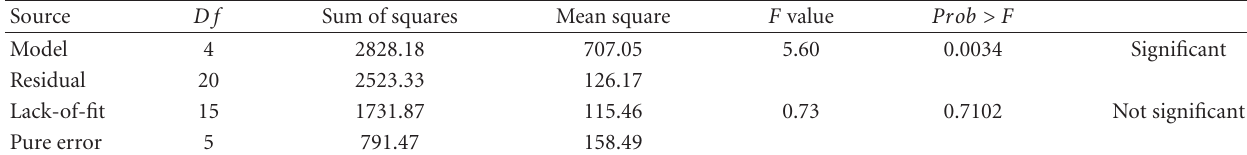
Table 4: Analysis of variance (ANOVA) for Y response of